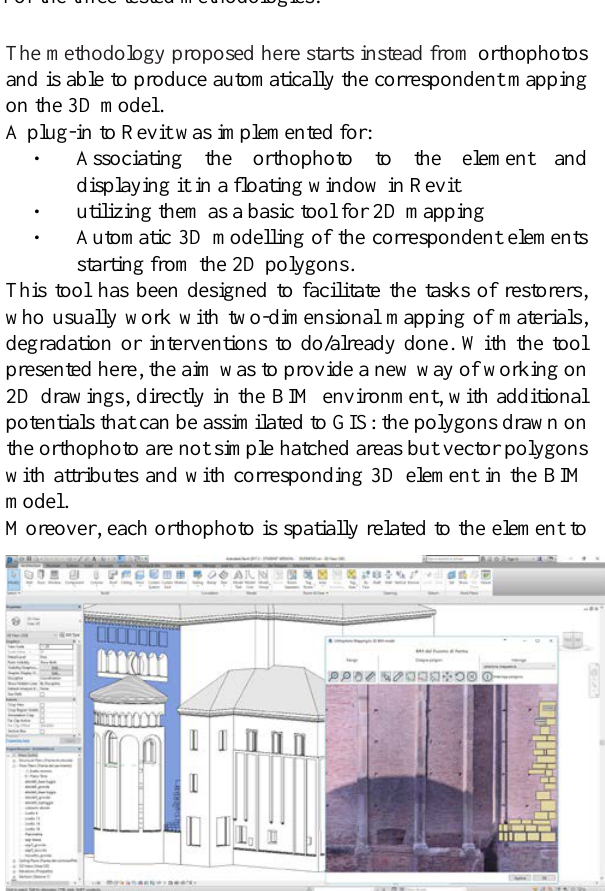
Figure 7_Summary and comparison of the three tested methodologies.